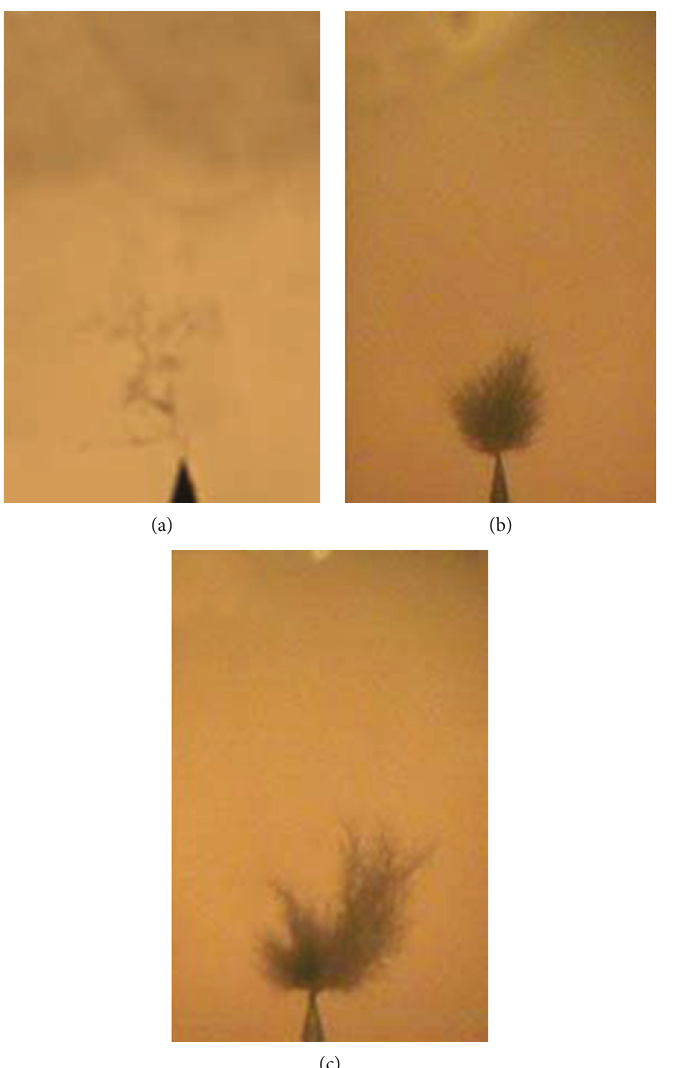
Figure 7: Treeing morphology in the propagation state for epoxy nanocomposites with di ff erent alkyl-modi fi ed nanosilica contents: (a) 0phr, (b) 1 phr, and (c)